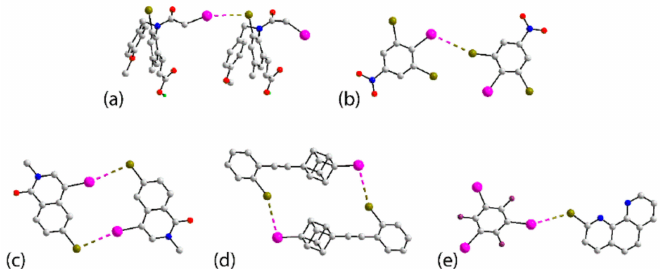
Figure 4. Zero-dimensional aggregates in the crystals of ( a ) 1 , ( b ) 3 , ( c ) 6 , ( d ) 7 and ( e ) co-crystal 9 . Additional colour code: nitrogen, blue; fluoride, plum; boron,